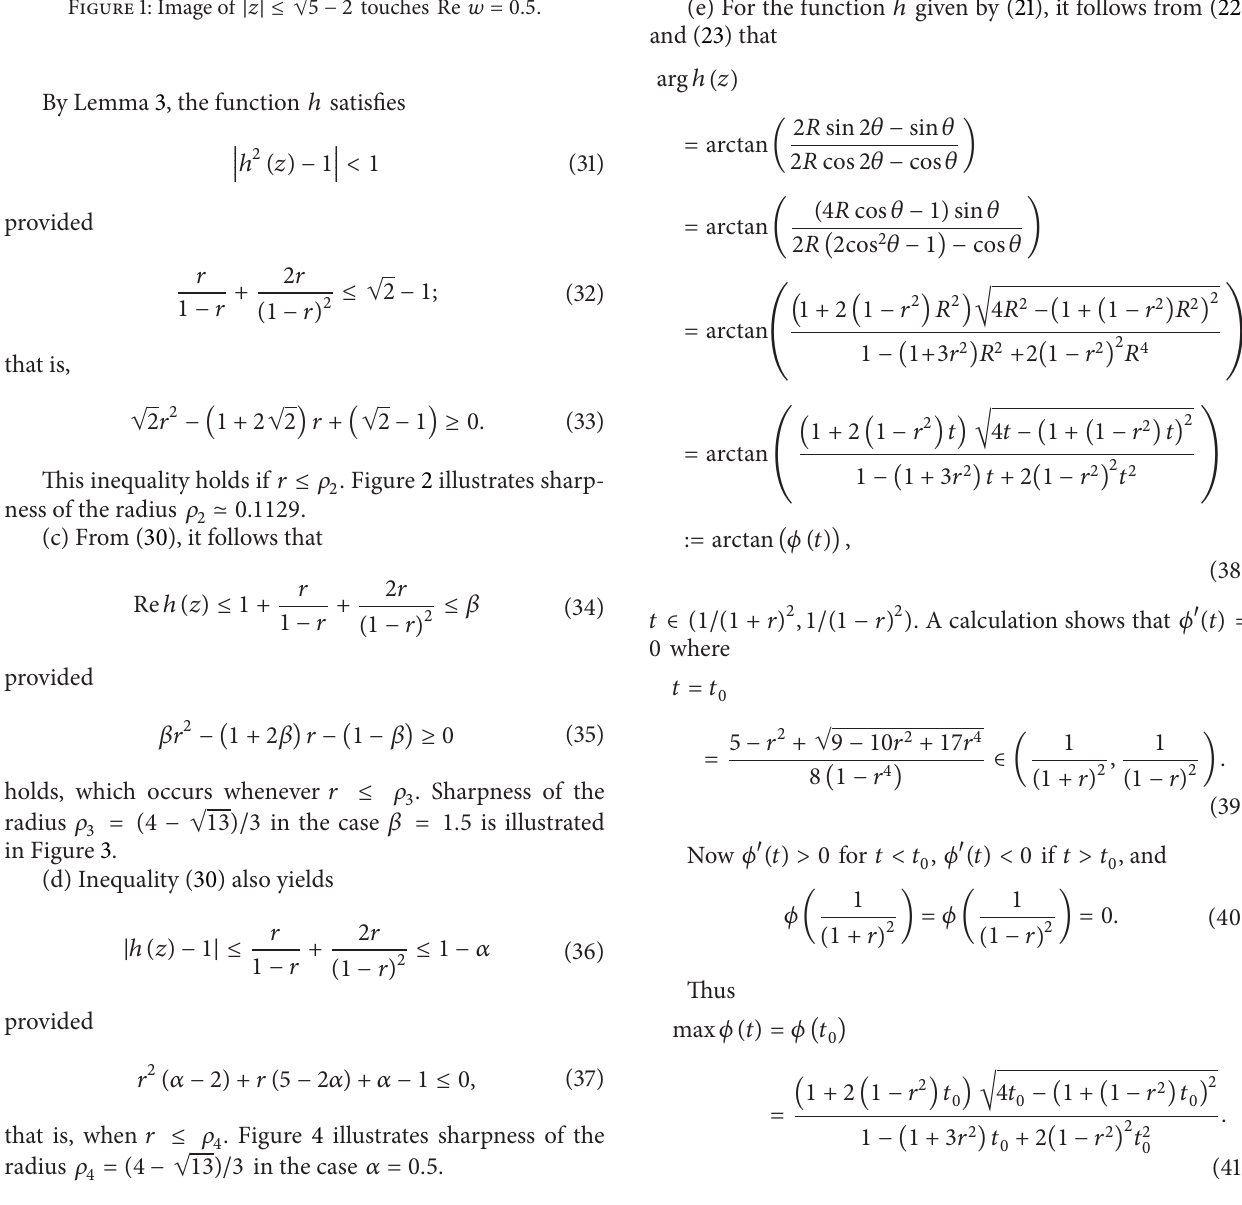
Figure 1: Image of |𝑧| ≤ √5 − 2 touches Re 𝑤 = 0.5 .